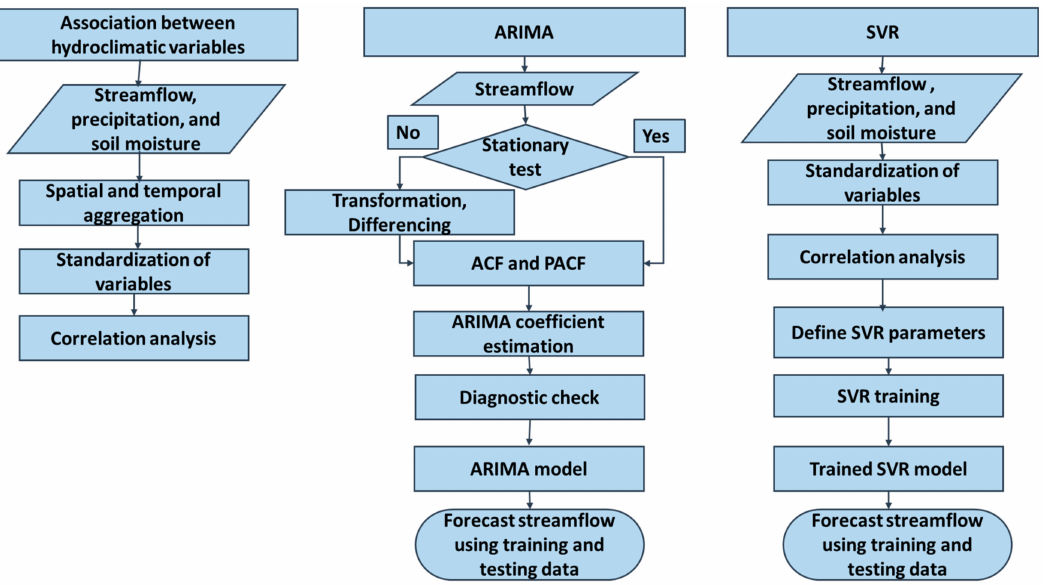
Figure 1. Schematic diagram of the methodology used in the